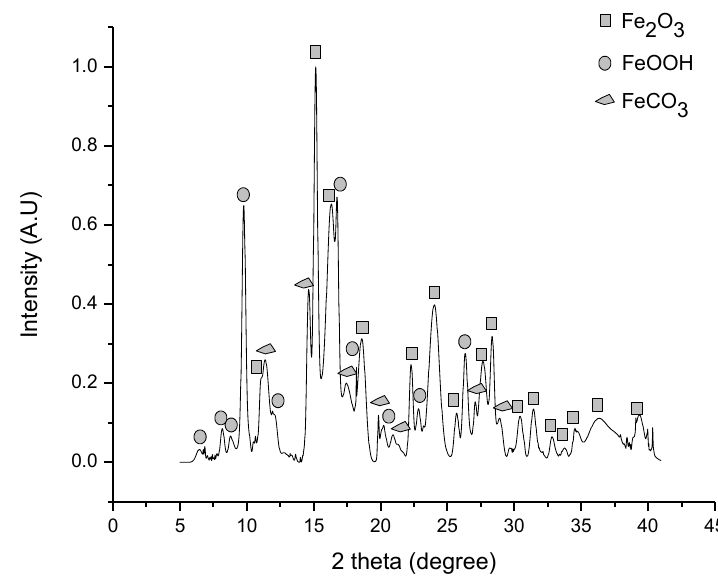
Figure 1. XRD pattern of iron ore sample.